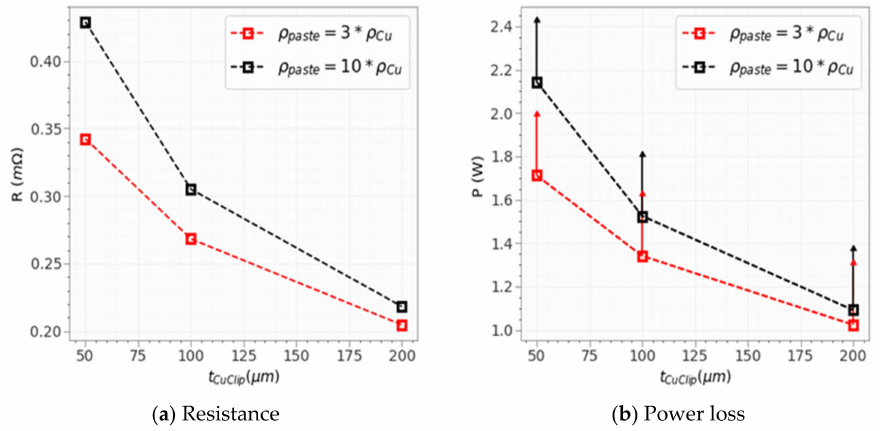
Figure 9. Electrical simulation results of resistance ( a ) and power losses ( b ) as a function of tCuClip in structure C. The red lines refer to ρ CuPaste = 3 × ρ Cu and the black lines to ρ CuPaste = 10 × ρ Cu. Arrows in panel ( b ) once again show the maximum expected contribution at f = 100 kHz of eddy effects on the power losses.